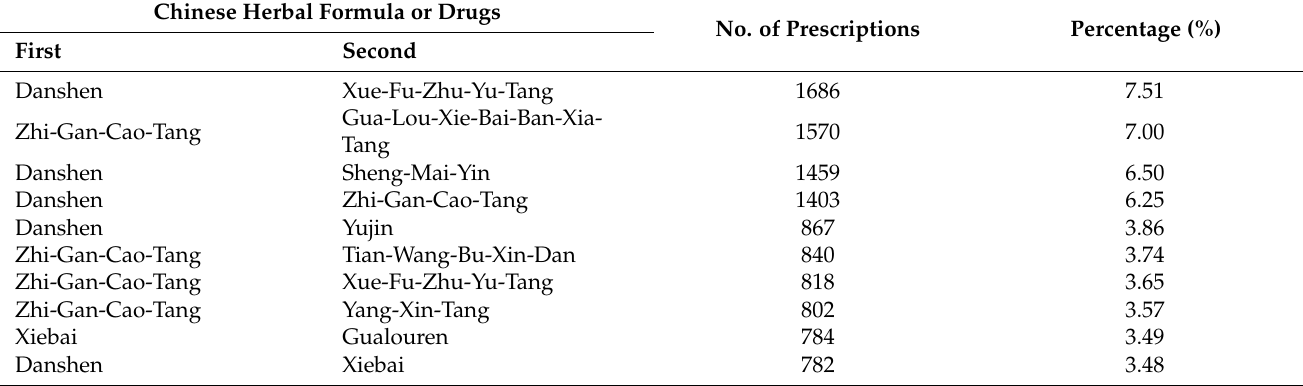
Table 6. The most common two-drug combinations of TCM in a single prescription for IHD (Total prescription number, n = 22,441).